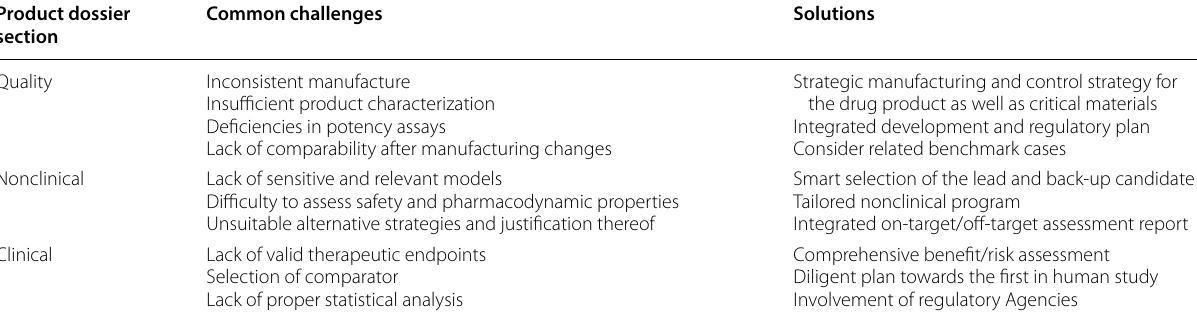
Table 4 Important considerations during gene editing-based drug development Product dossier